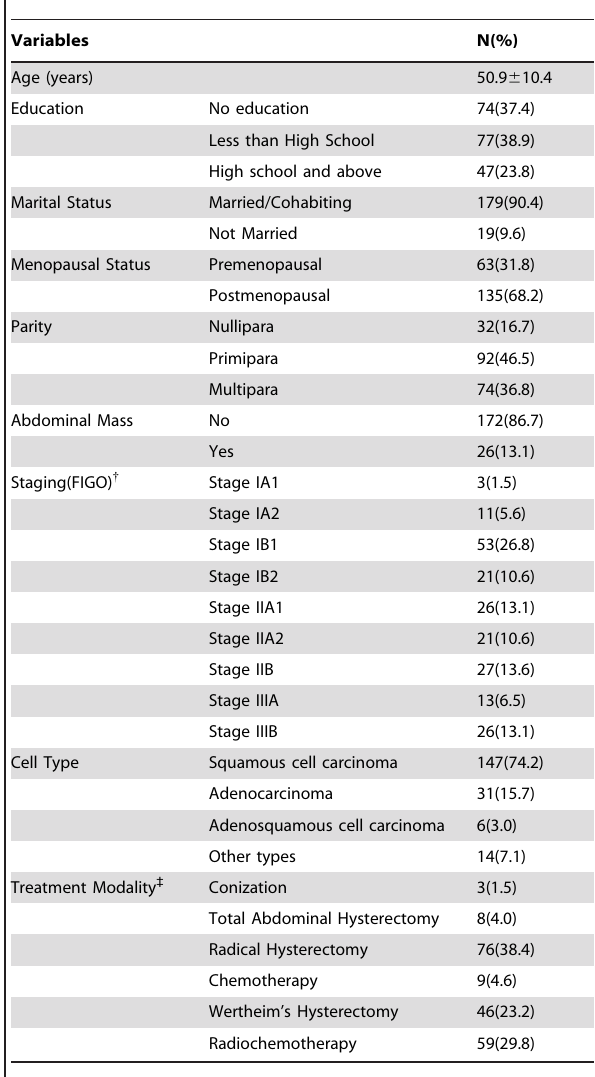
Table 1. Demographic and clinical characteristics of the patient